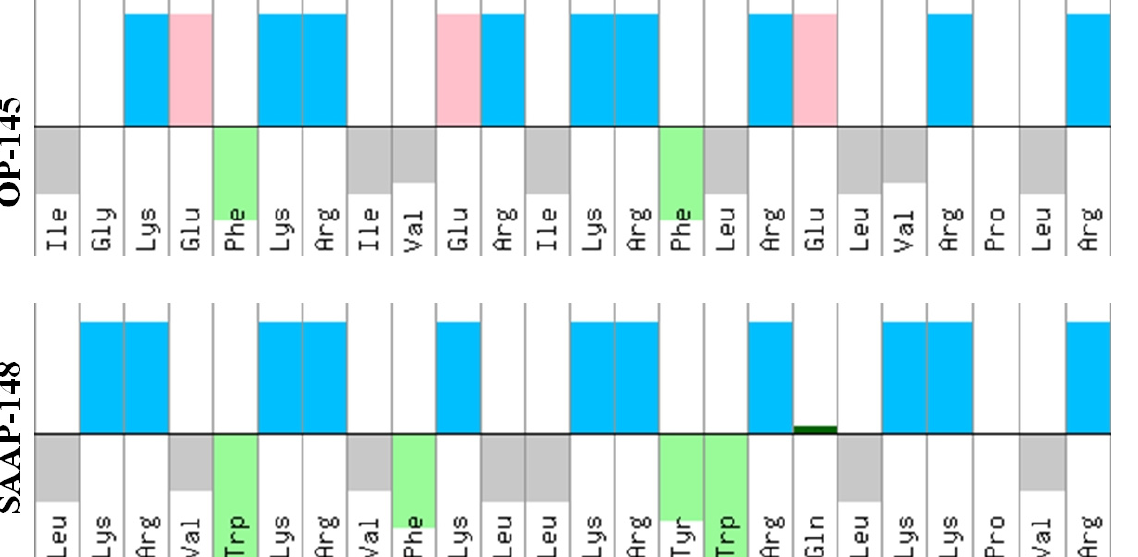
Figure 2. Cell envelopes of Gram-negative and Gram-positive bacteria. Negatively charged lipids distributed across the outer membrane (OM) and cytoplasmic membrane (CM) are shown in blue.